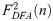
Illustration of DFA.Top left: two signals Xi(t) uncorrelated (green) and LRTC (red) from top to bottom with Hurst exponents H1 = 0.5 < H2. Top-right: the cumulative sum x(t) of the original signal, which display differing random walk behaviours. Bottom left: the DFA coefficients FDFA2(n) are estimated by detrending x(t) in time windows of length n and estimated the error of the linear fit. Botton right F2(n) n2H allowing H to be estimated by regression in log coordinates.